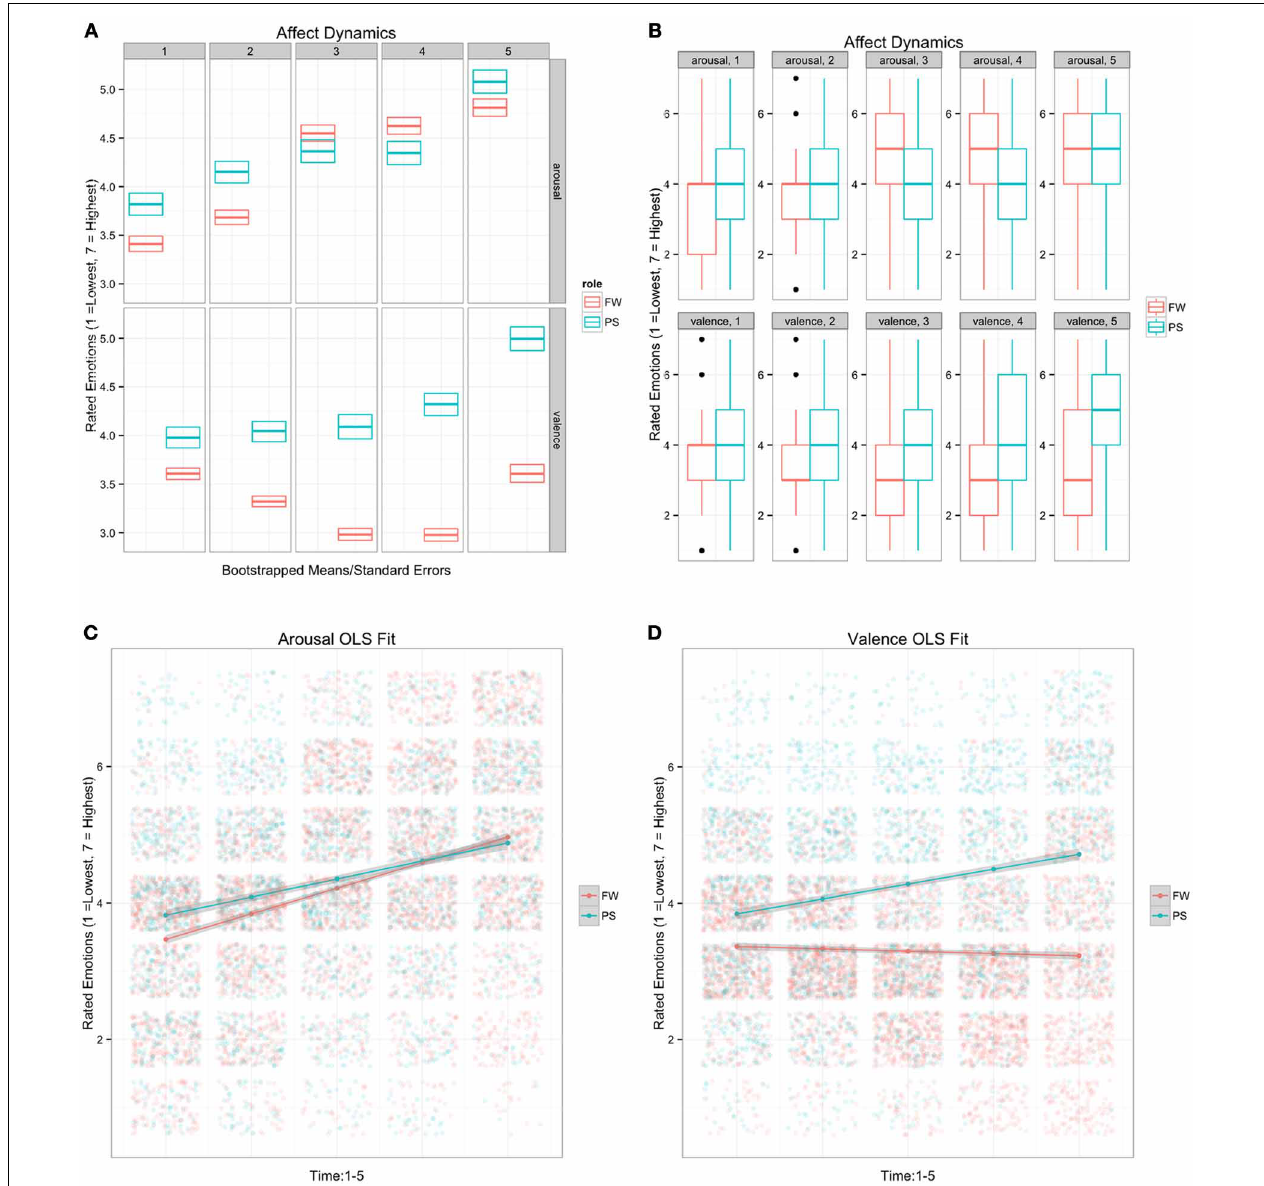
FIGURE 3 | Data presents exploratory graphs of the role-by-time trend using classical Ordinary Least Squares (OLS) estimation. Panel (A) shows bootstrap means and standard errors from OLS regression, indicating statistically significant main effects for the interactions of role and time on both arousal and valence. Boxplots in Panel (B) and raw data plots with regression lines for (C) arousal and (D) valence suggest broad response variances among ratings of individual participant expressions at the different stages of the ritual. Doubt about the extent to which this diffuse pattern depends on rater effects must be included